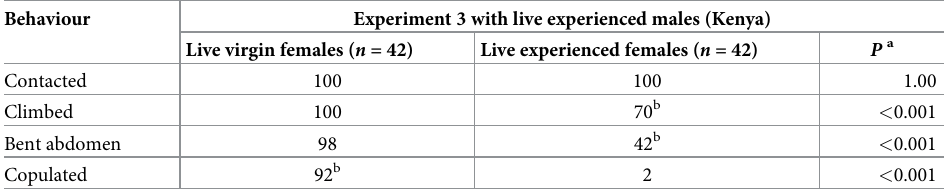
Table 2. The percentage of male-female pairs that exhibited each mating behaviour in the sequence of mating behaviours for live experienced males with either live virgin females or live experienced females in Kenya. Behaviour Contacted Climbed 100 < 0.001 Bent abdomen 98 42 b < 0.001 Copulated 92 b 2 < 0.001